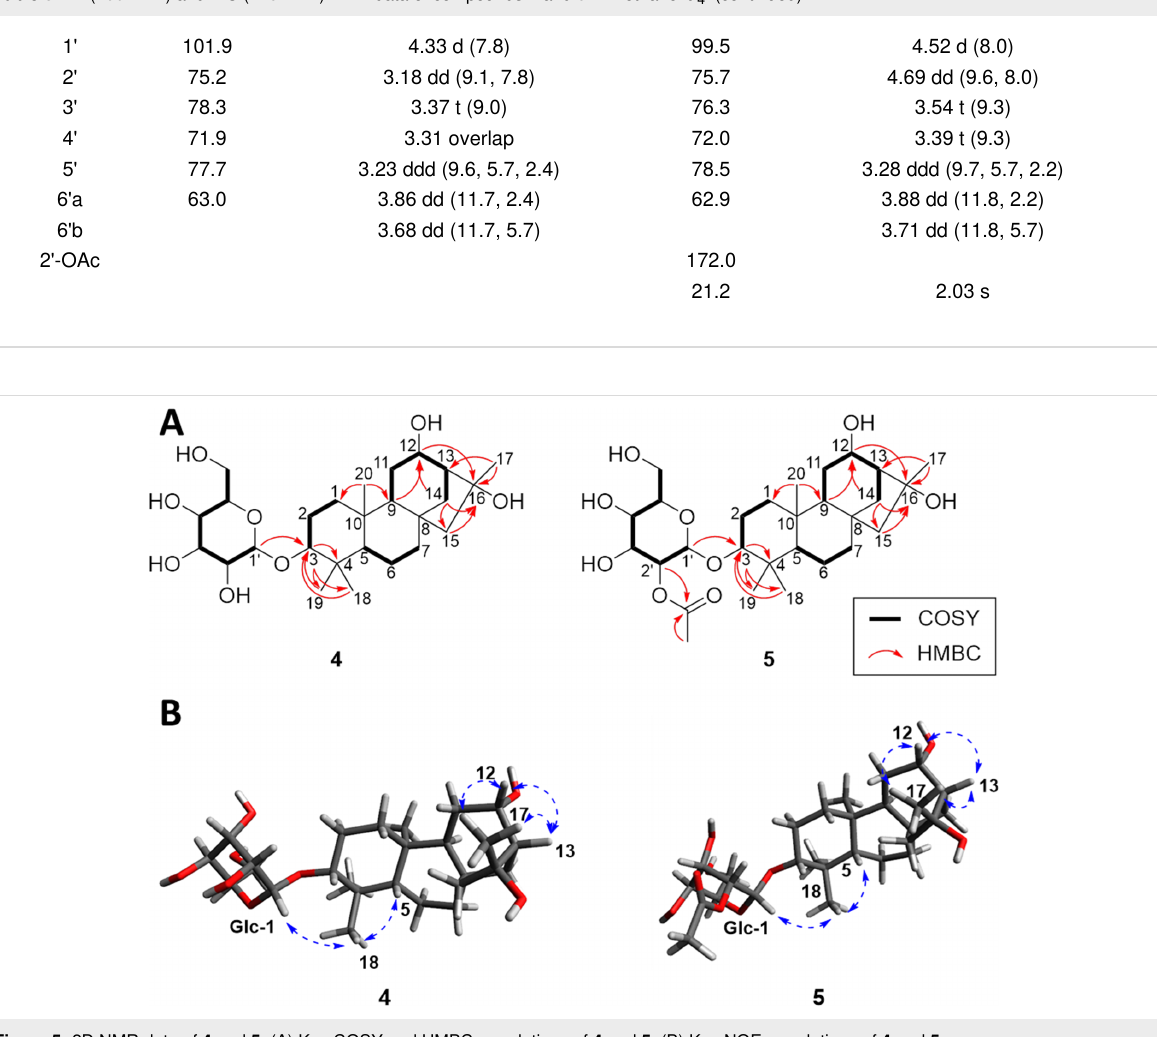
Figure 5: 2D NMR data of 4 and 5 . (A) Key COSY and HMBC correlations of 4 and 5 . (B) Key NOE correlations of 4 and 5 .